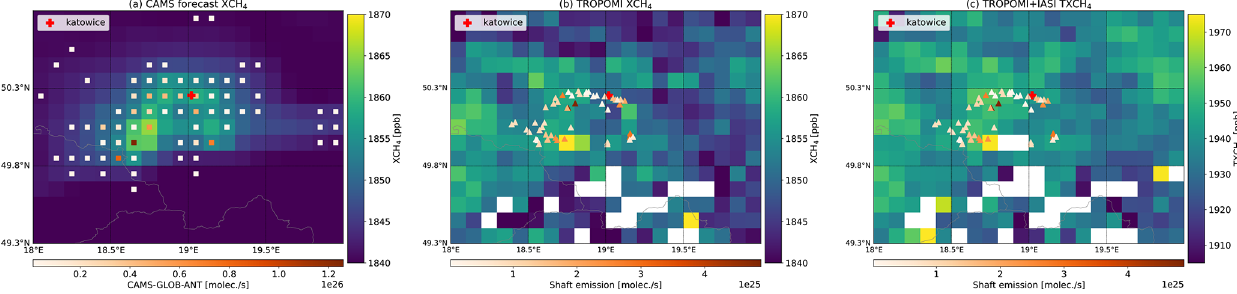
Figure 4. Averaged (a) CAMS forecast XCH 4 , (b) TROPOMI XCH 4 , and (c) TROPOMI + IASI TXCH 4 in the USCB region on a 0.1 ◦ × 0.1 ◦ latitude/longitude grid during November 2017–December 2020. The square and triangle symbols represent the locations of CAMS-GLOB-ANT sources (for better viewing, only the emission strengths larger than 1 × 10 24 molec.s − 1 are shown here) and the active coal mine shafts from the CoMet inventory (Gałkowski et al., 2021a), respectively. Different colors denote the amount of emission rates. The white grids represent no data from TROPOMI or the number of the points in the grid less than 5. A zoomed version of panel (b) is shown in the appendix (Fig. A2). Note that a different color bar has been used in panel (c) .